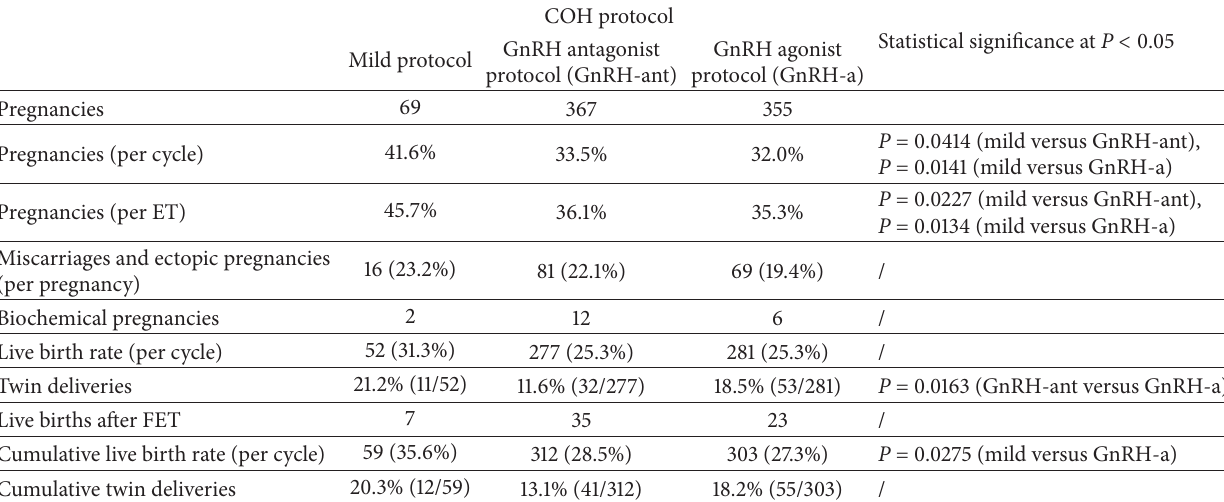
Table 2: The outcome of COH in terms of pregnancies, miscarriages, and